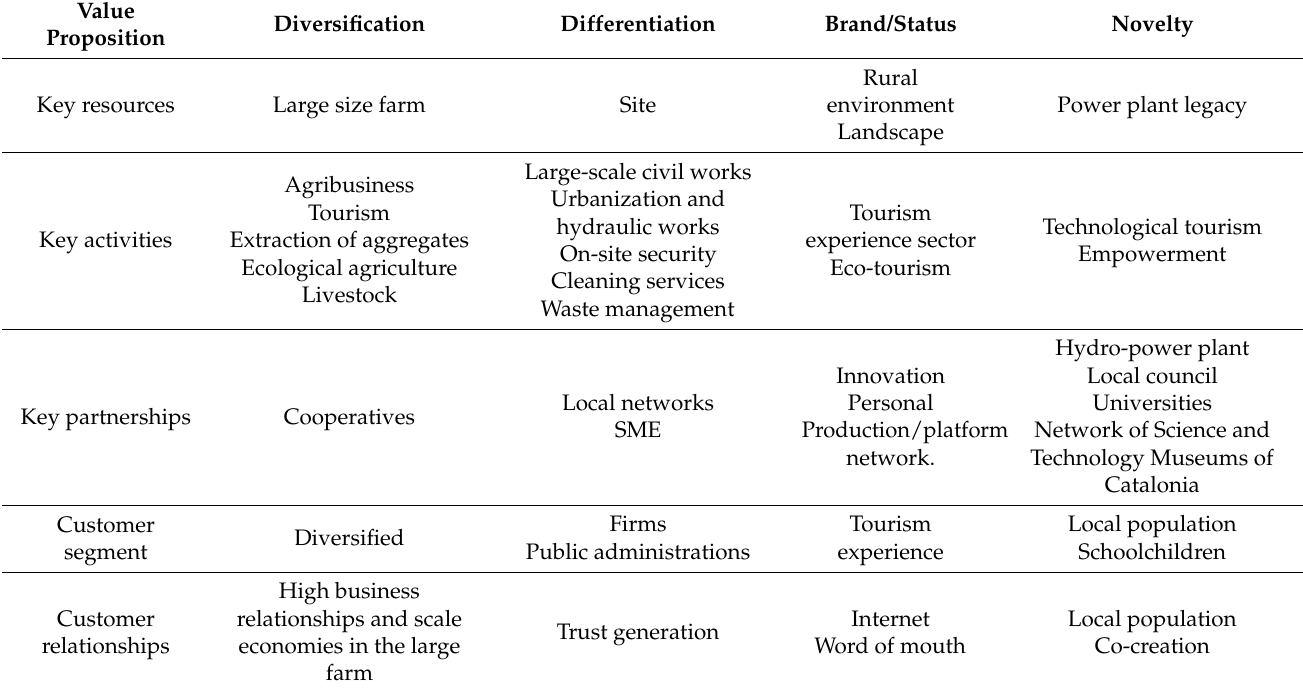
Table 5. Summary of economic activities and their value propositions for